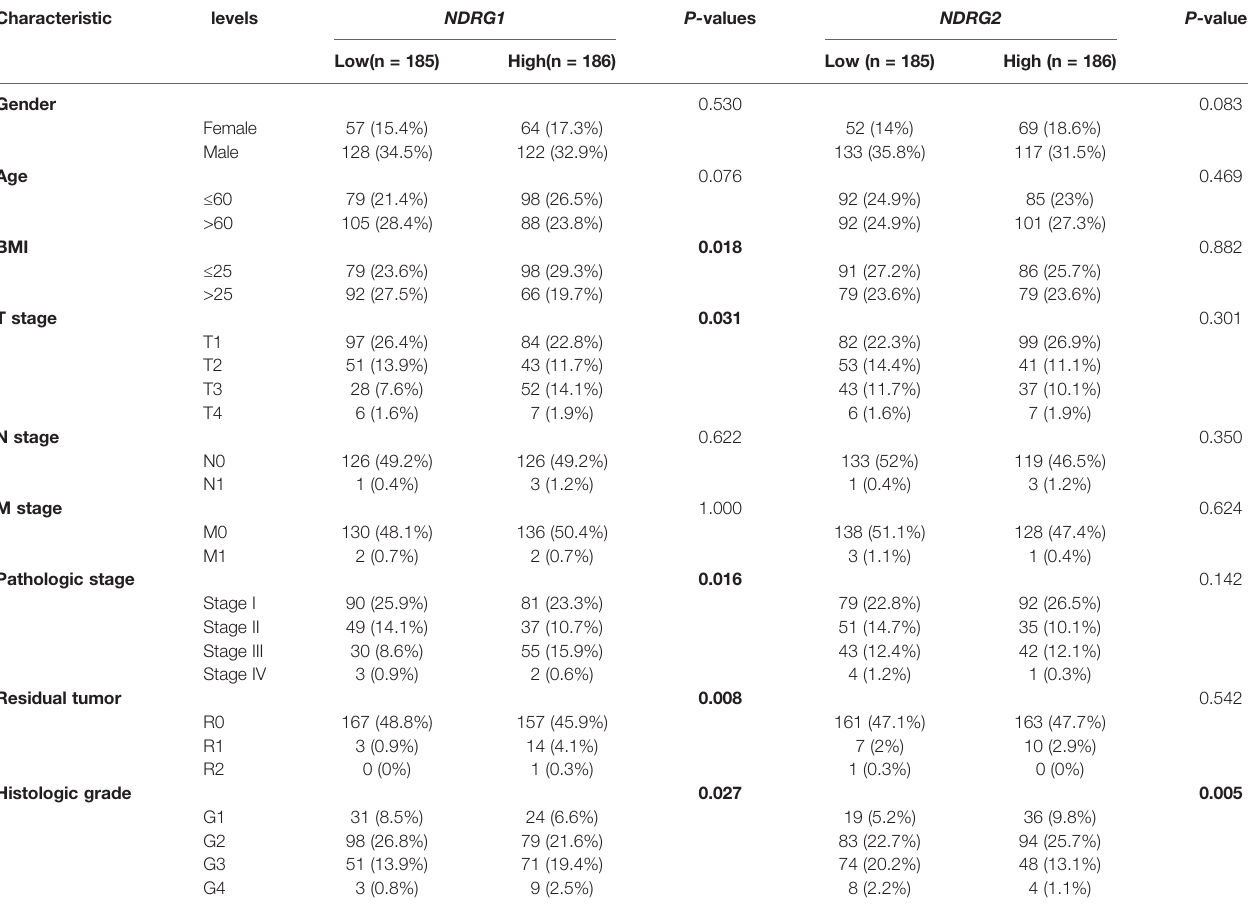
Bold indicates signi fi cant differences. cancers (37), and its occurrence in the promoter region often results in gene silencing (38). In this study, the methylation of NDRG1 and NDRG2 was related to the clinical prognosis of LIHC patients, and patients with hypomethylated NDRG1 or hypermethylated NDRG2 had worse OS. Of note, their mRNA expression was consistent with DNA methylation levels for